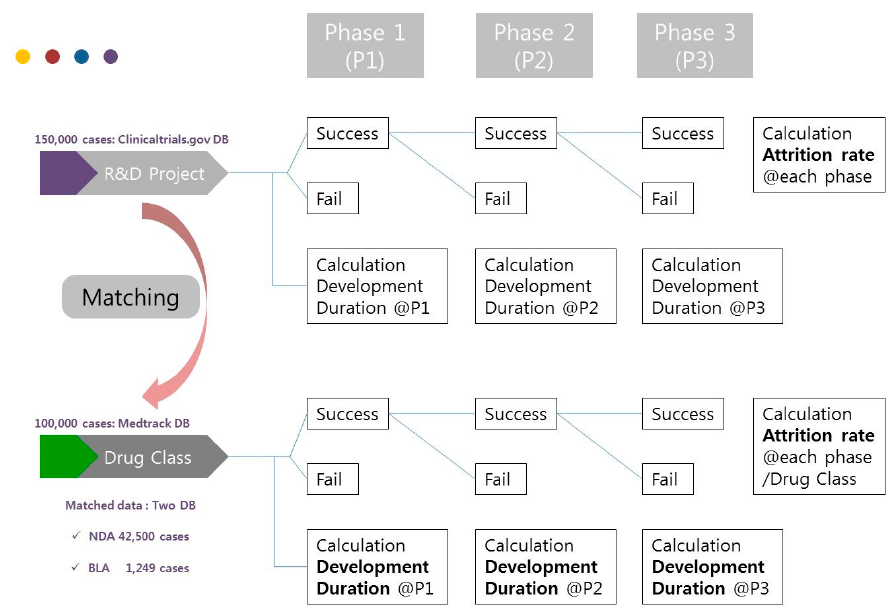
Figure 1. Analytical method.